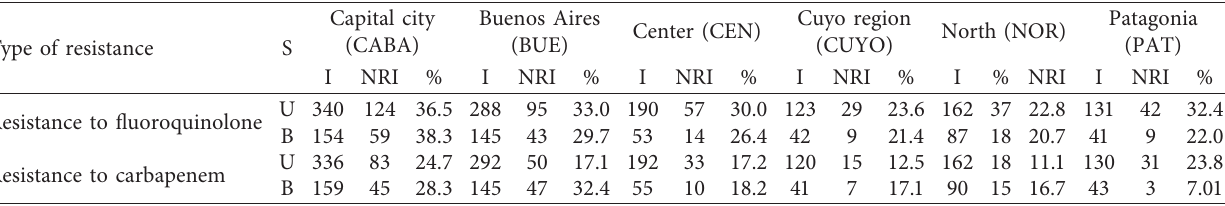
Table 3: The carbapenem and fluoroquinolone resistance rates in Pseudomonas aeruginosa according to each geographical region of Argentina during 2018.